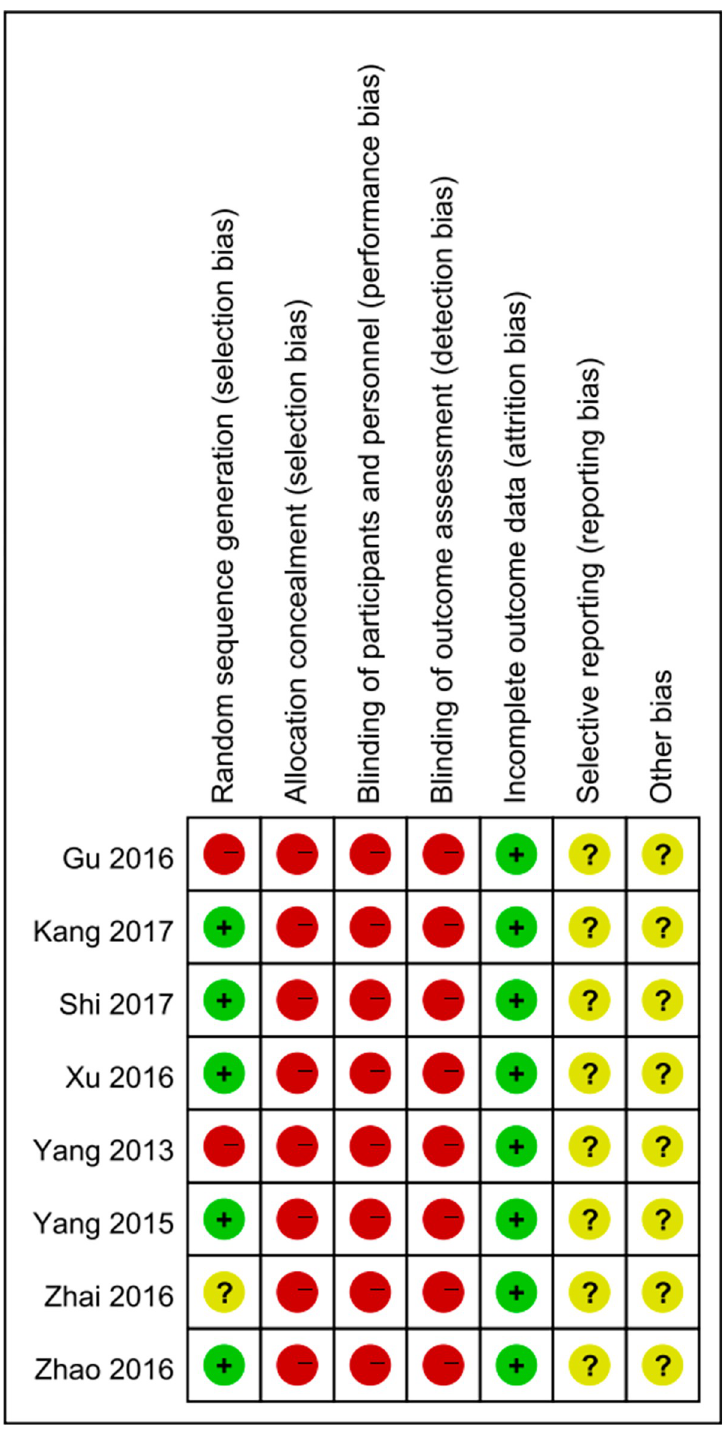
Fig 2. The risk of bias of all included studies. The red represents high risk; the green represents low risk; the yellow represents unclear risk.